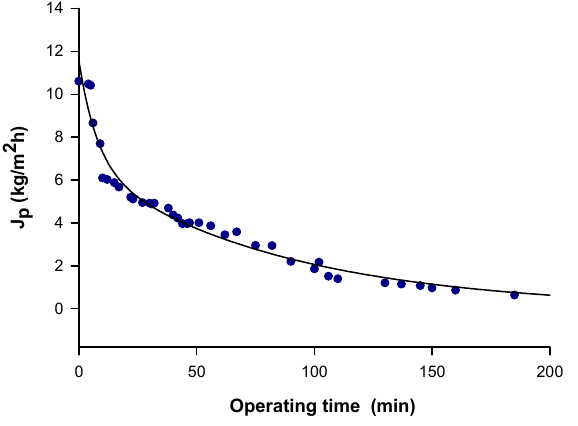
Figure 3. Nanofiltration of microfiltered olive mill wastewaters. Time course of permeate flux (transmembrane pressure, 7 bar; feed flowrate, 188 L/h; temperature, 25 ± 1 °C).